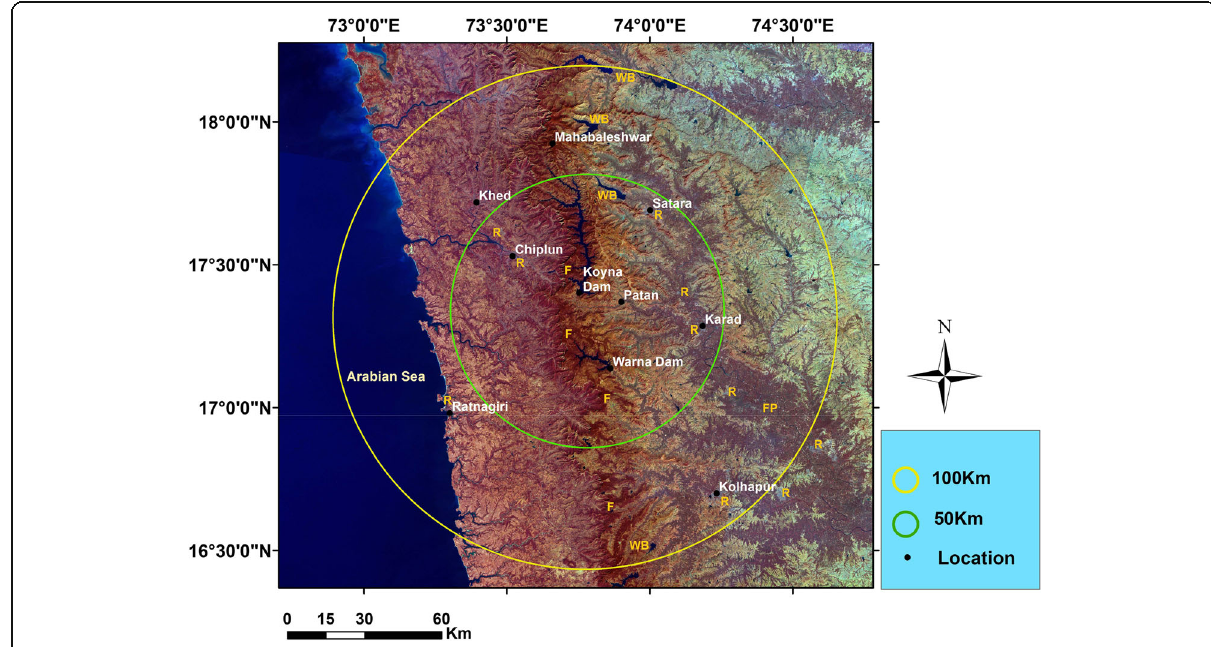
Fig. 5 False colour composite of the Landsat-7 ETM+ image 20th October 1999 showing the land cover